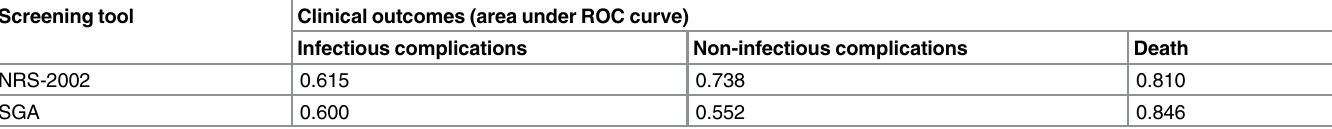
Table 5. Clinical outcomes and area under ROC curve values of the two nutritional screening tools according to evaluated outcomes. Screening